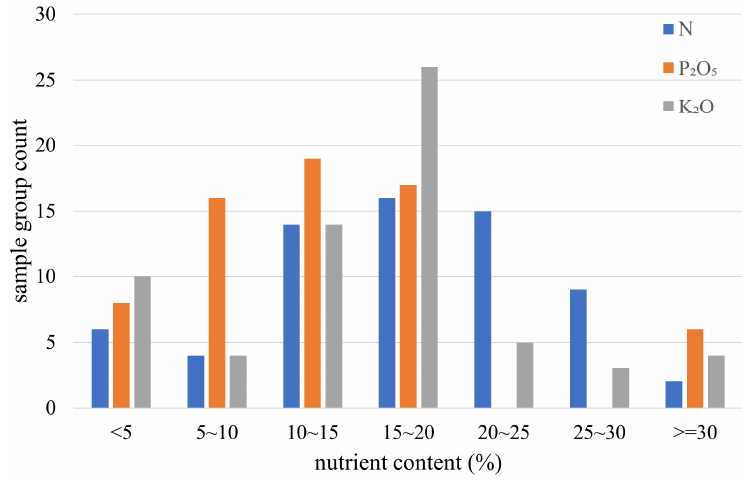
Figure 1. Distribution of N, P 2 O 5 , K 2 O content in samples.